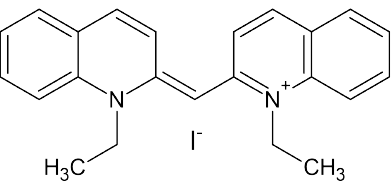
Figure 8. Chemical structure of decynium-22 (D22). D22 was used in all subsequent graphs as a highly potent transporter inhibitor for the assessment of unspecific uptake of the tritiated substrate [ 3 H ] -MPP +